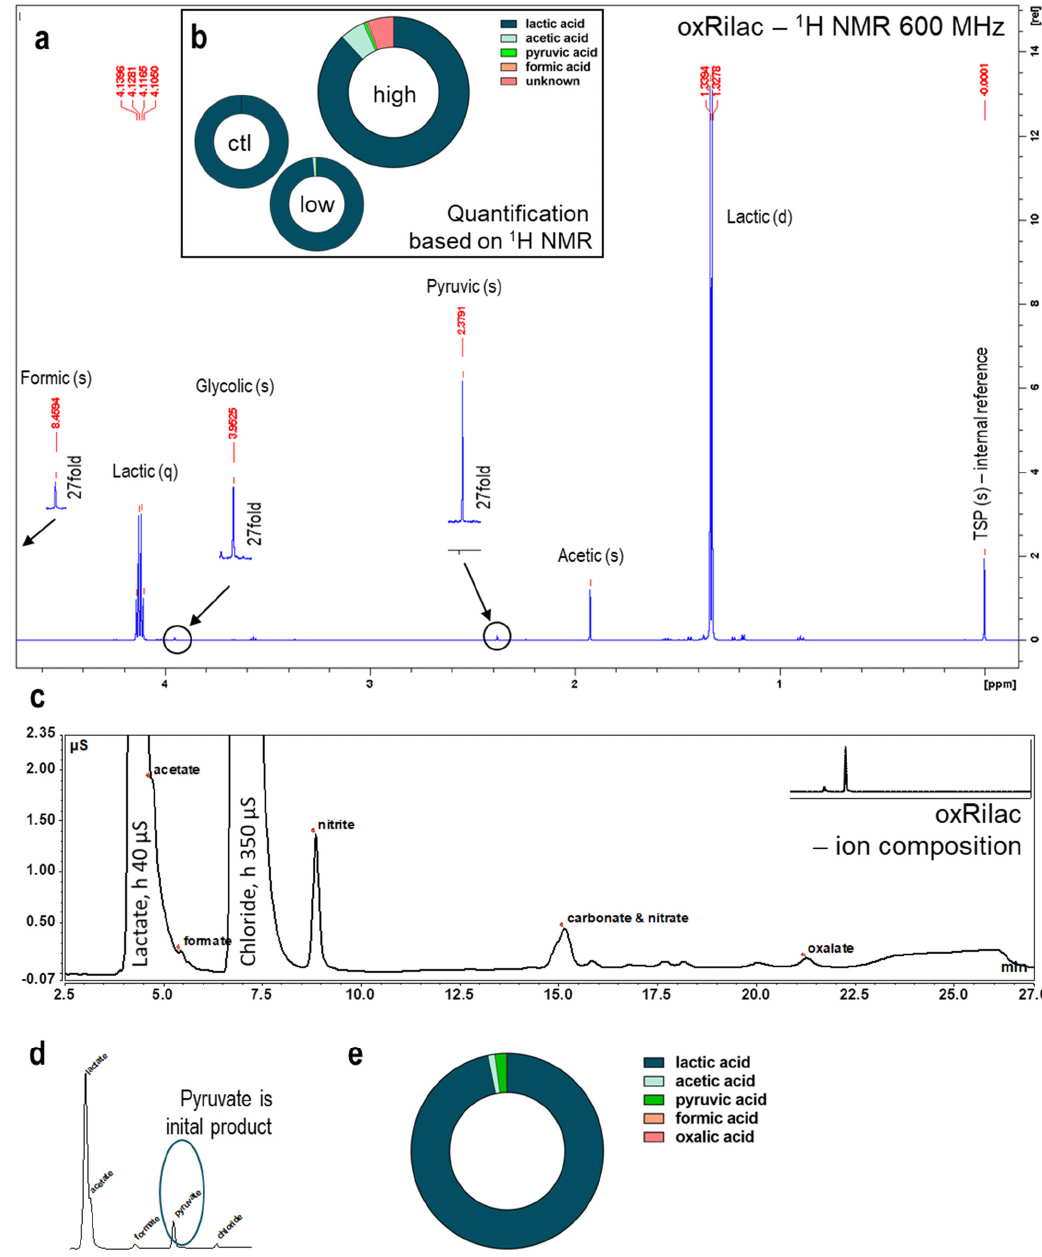
Figure 4. Gas plasma treatment of Ringer’s lactate solutions yields lactate oxidation. ( a ) 1 H-NMR spectrum of oxRilac in the range from δ = 0 to δ = 4.8 reveals lactate signals (doublet δ = 1.33, quadruplet δ = 4.12), acetic acid as major product (singulet δ = 1.91), smaller signals belonging to pyruvic acid (singulet δ = 2.38) and glycolic acid (singulet δ = 3.95), and formic acid (singulet δ = 8.46), apart from contaminants (disinfectants) on the control level; ( b ) quantification of educts and products in control (Ringer’s lactate solution with 25 mM of lactate) and extended (10 min) gas plasma-treated samples (22.1 ± 0.5 mM of lactate, 1.5 ± 0.1 mM of known products, 1.4 ± 0.1 mM of unknown products) as well as short treatment (1 min) conditions (1.5% products, mainly acetic acid); ( c ) oxRilac ion chromatogram showing lactate (R T = 4.13 min) and chloride ions (R T = 6.55 min); acetate (lactate peak shoulder), formate, and oxalate; ( d ) pyruvate is detectable through ion chromatography imme- diately after gas plasma treatment in Ringer’s solution without chloride ions; ( e ) ion chromatography quantification reveals abundant pyruvate ( ≈ 430 µ M) and acetate ( ≈ 250 µ M) and only minor traces of oxalate (25 µ M) and formate (6 µ